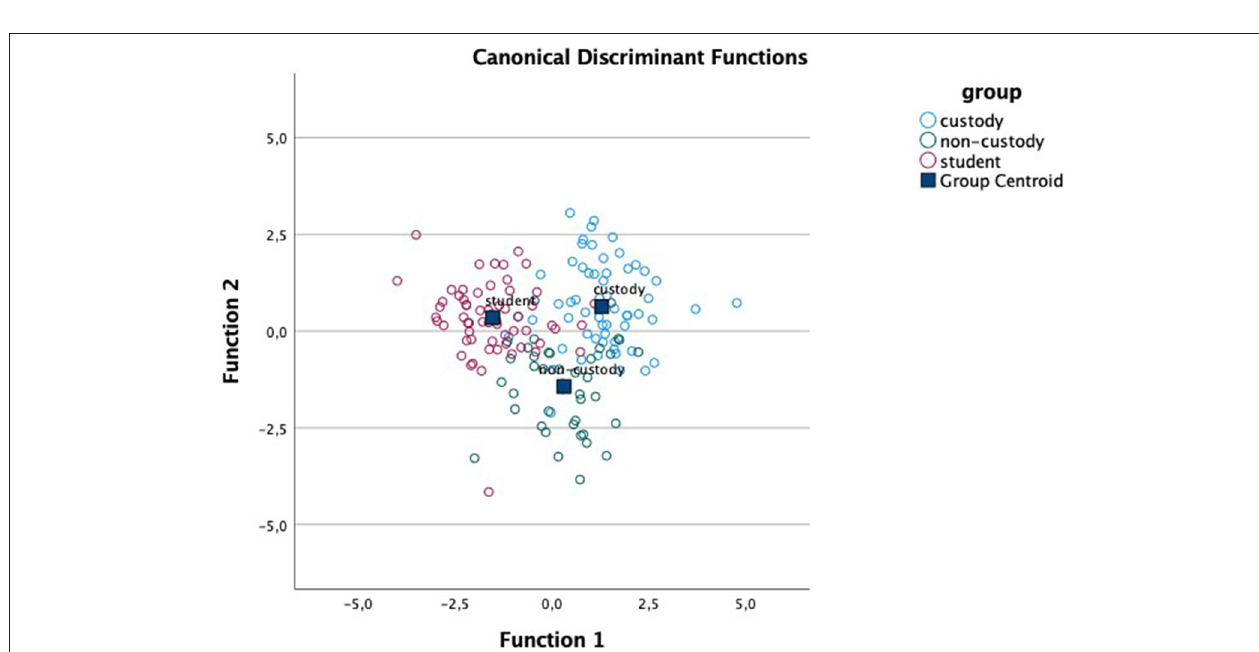
FIGURE 2 | Canonical discriminant functions for the dimension of